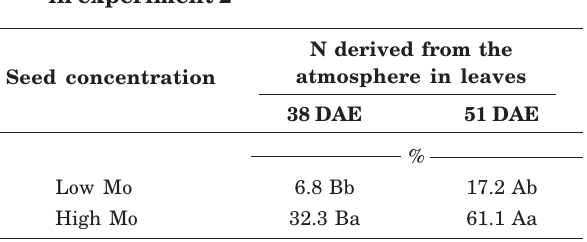
Table 5. Contribution of biological N 2 fixation (estimated by the 15 N isotope dilution technique) in leaves of common bean plants inoculated with rhizobia and originating from seeds with low or high Mo concentration, at two growth stages (in days after emergence - DAE), in experiment 2